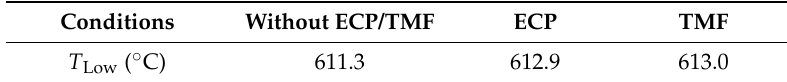
Table 2. Influence of the applied ECP and TMF on the T Low of Al-7 wt. %Si